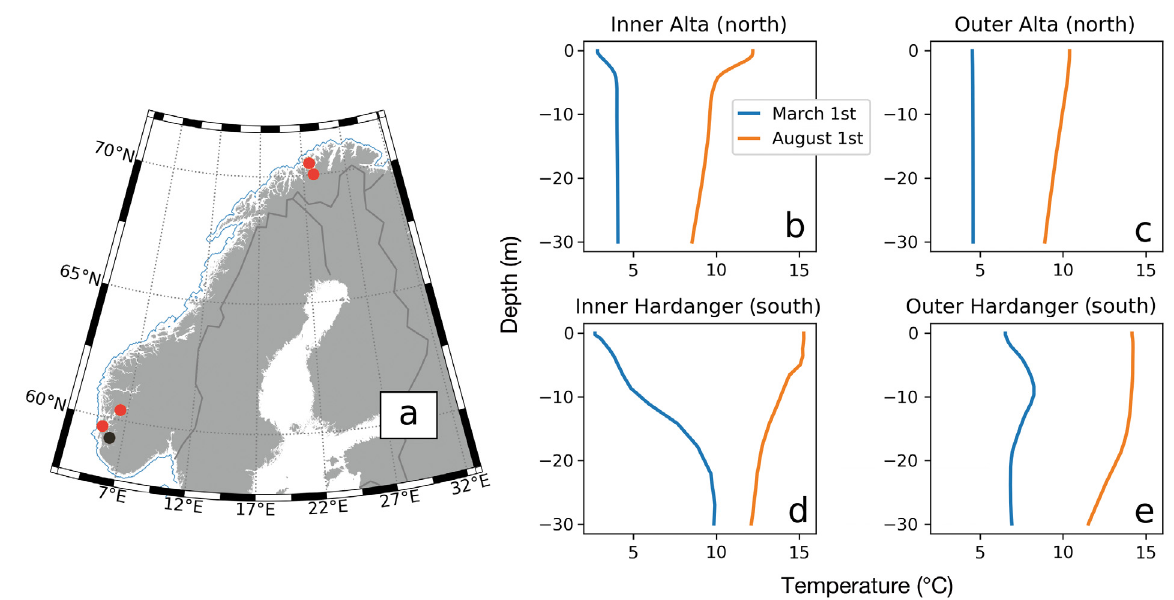
Fig. 1. (a) Scandinavian Peninsula. Blue line: Norwegian coastline, with the shortest distance to this line used for gridding of data. Black dot: fish farm Langavika. Red dots: geographical positions of the vertical temperature profiles in (b−e). (b−e) Temperature profiles from 1 March and 1 August in a (b,c) northern and (d,e) southern